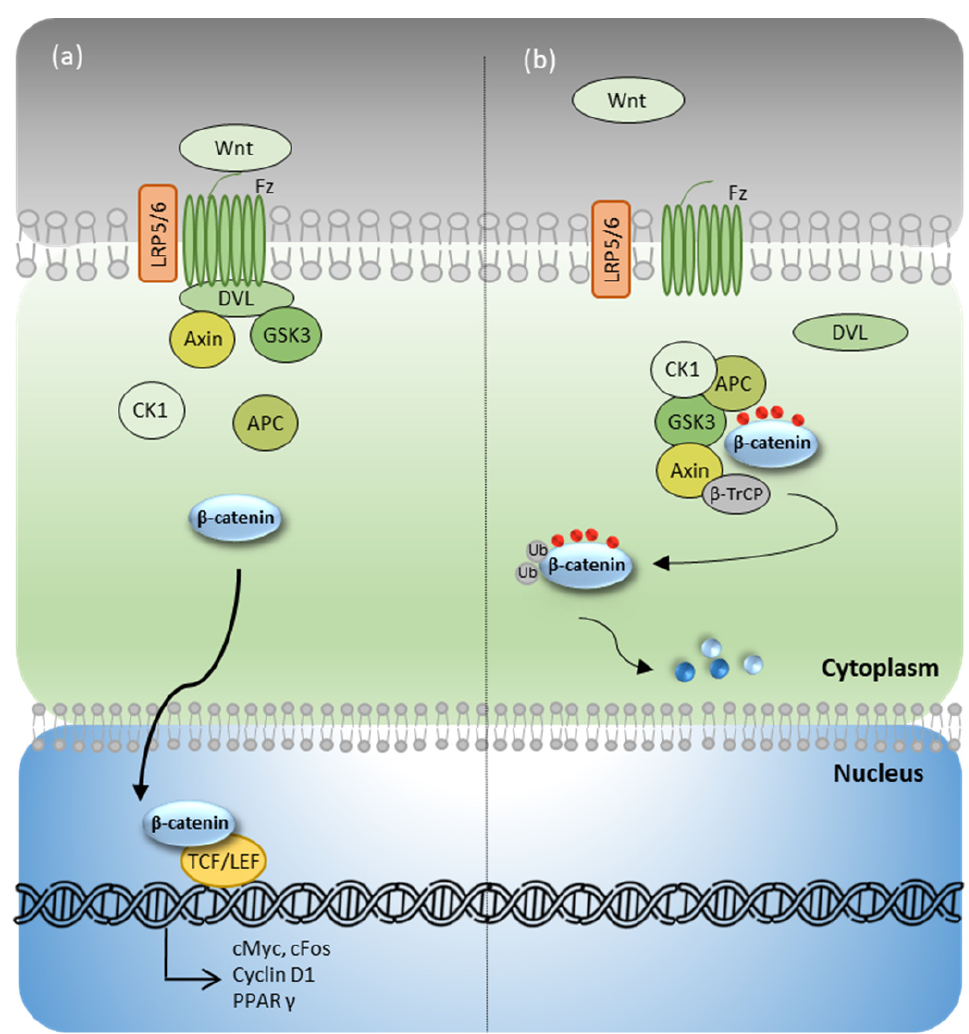
Figure 1. Wnt/ β -catenin pathway. ( a ) Wnt/ β -catenin pathway in the presence of Wnt ligand. ( b ) Wnt/ β -catenin pathway in the absence of Wnt ligand. APC: adenomatous polyposis coli; β -TrCP: beta-transducin repeat containing E3 ubiquitin protein ligase; CK1: casein kinase 1; DVL: Dishevelled; Fz: Frizzled receptor; GSK3 β : glycogen synthase kinase 3 β ; LRP5/6: low-density lipoprotein receptor-related proteins 5 and 6; PPAR γ : peroxisome proliferator-activated receptor gamma; TCF/LEF: T cell factor/lymphoid enhancer factor family.